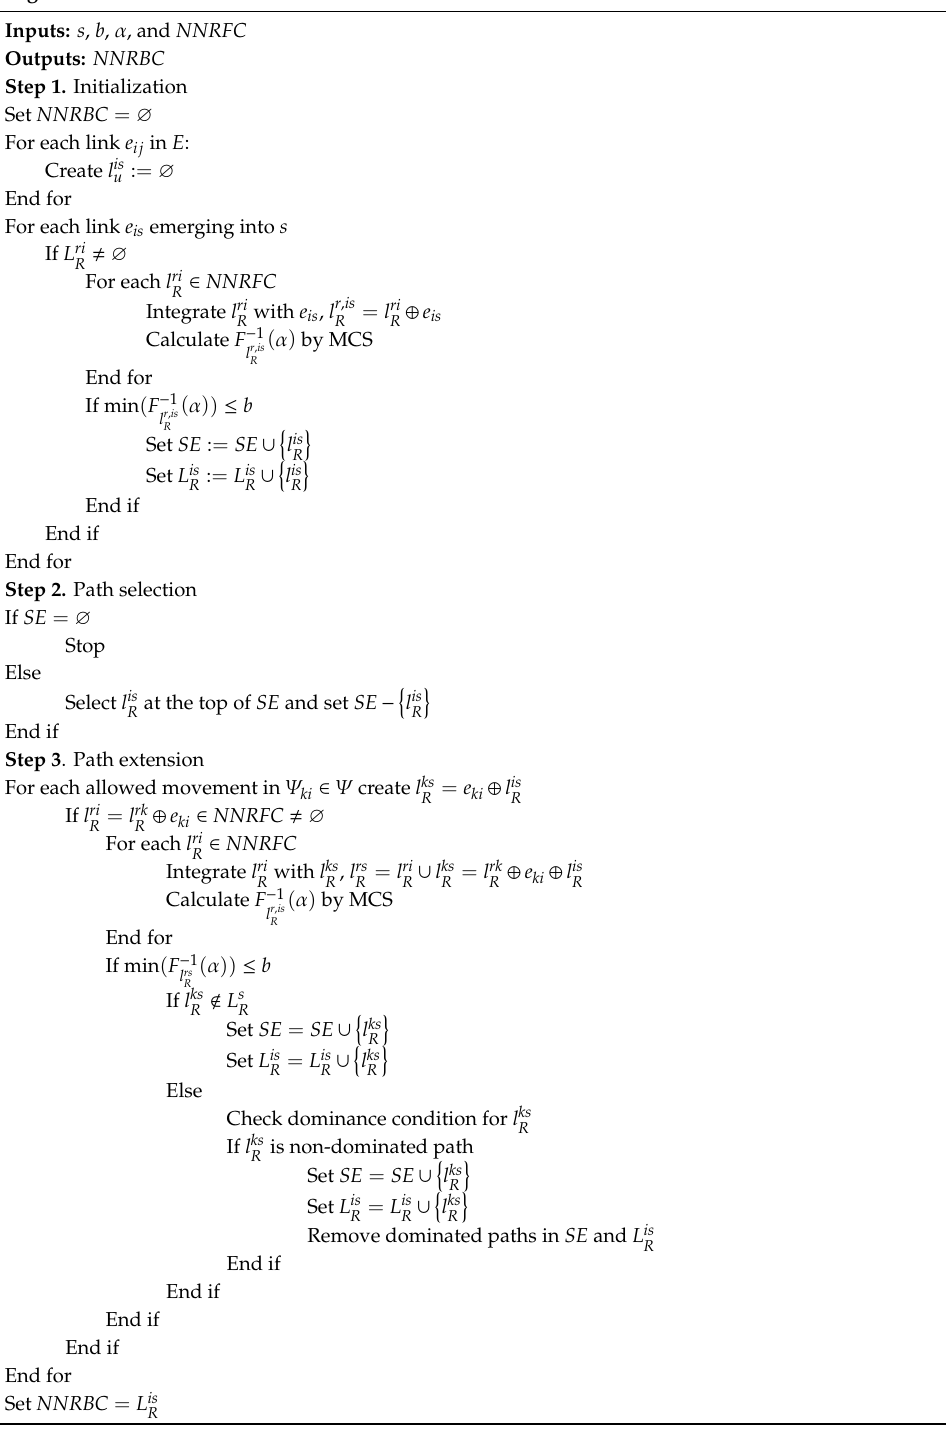
Algorithm 2. Backward cone